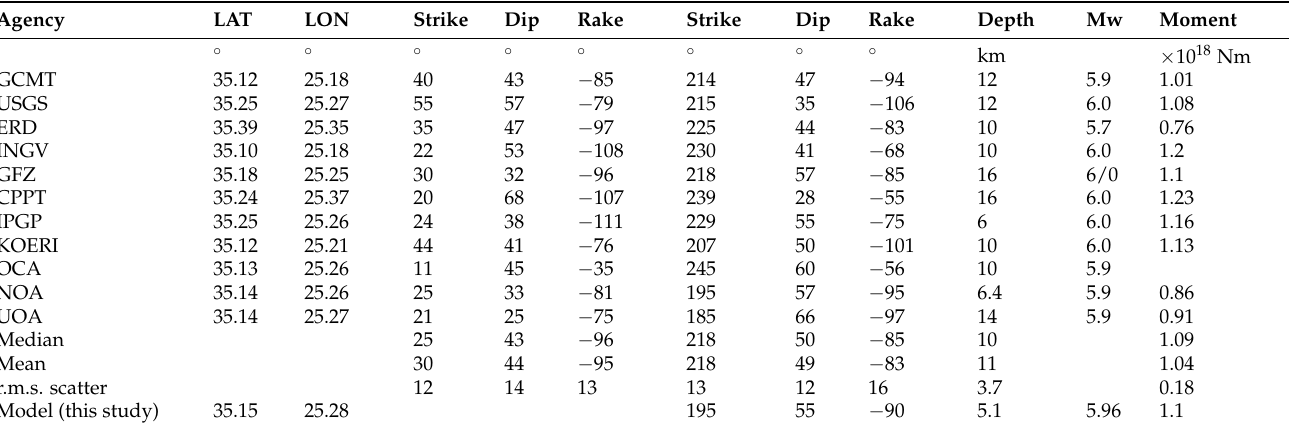
Table 1. Moment tensor solutions calculated by various agencies. In the last line, the values of our best fitting geodetic model (see Section